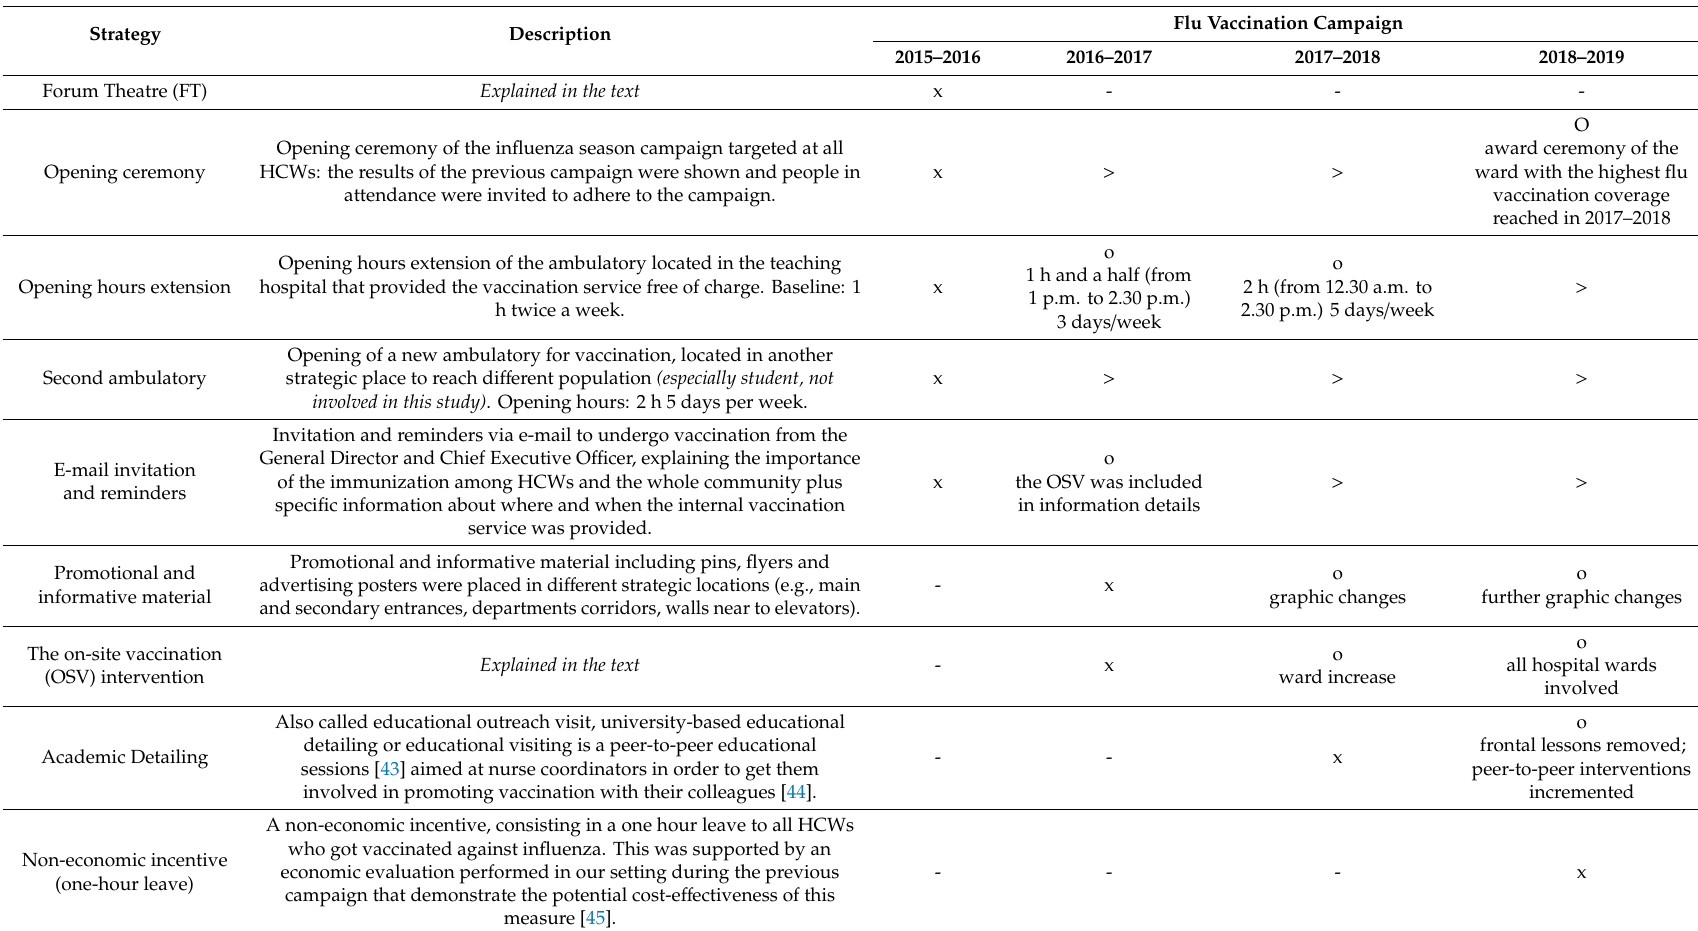
Table 1. Strategies implemented since 2015–2016 flu vaccination